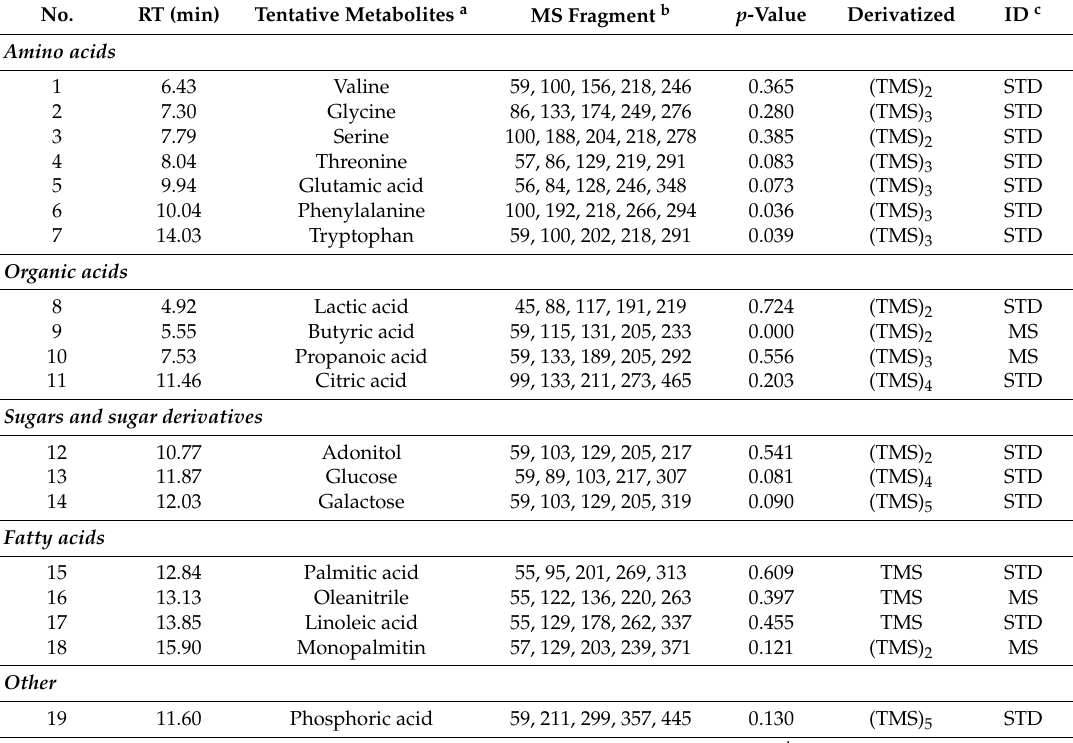
Table 2. Discriminant plasma metabolites identified using GC-TOF-MS in different rat groups. No.